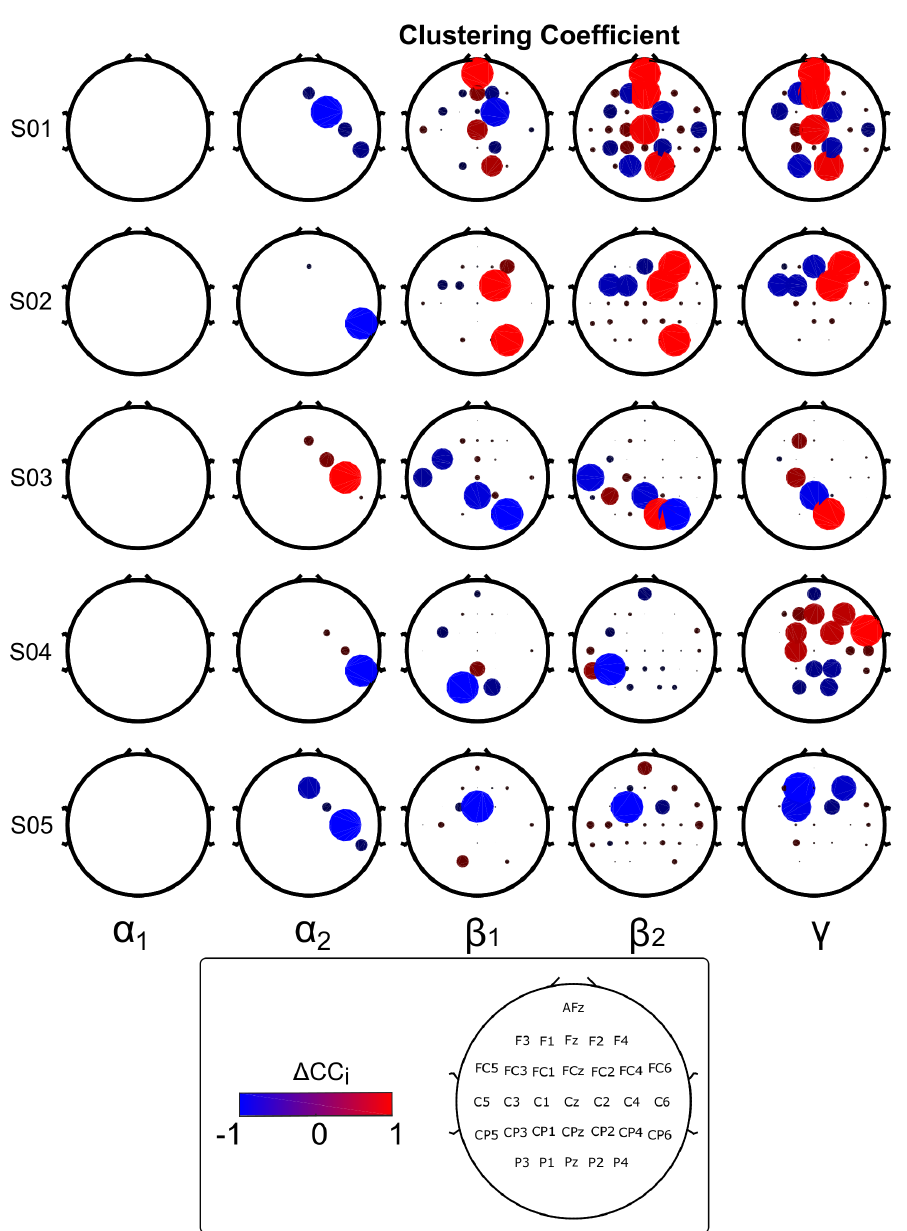
Figure 6. CC variations between pre- and post-intervention for all subjects and frequency bands; r = 0.75 and ρ = 0.30. Plotted radii are subject-specific. Only statistically significant variations are shown ( p < 0.00002; Wilcoxon